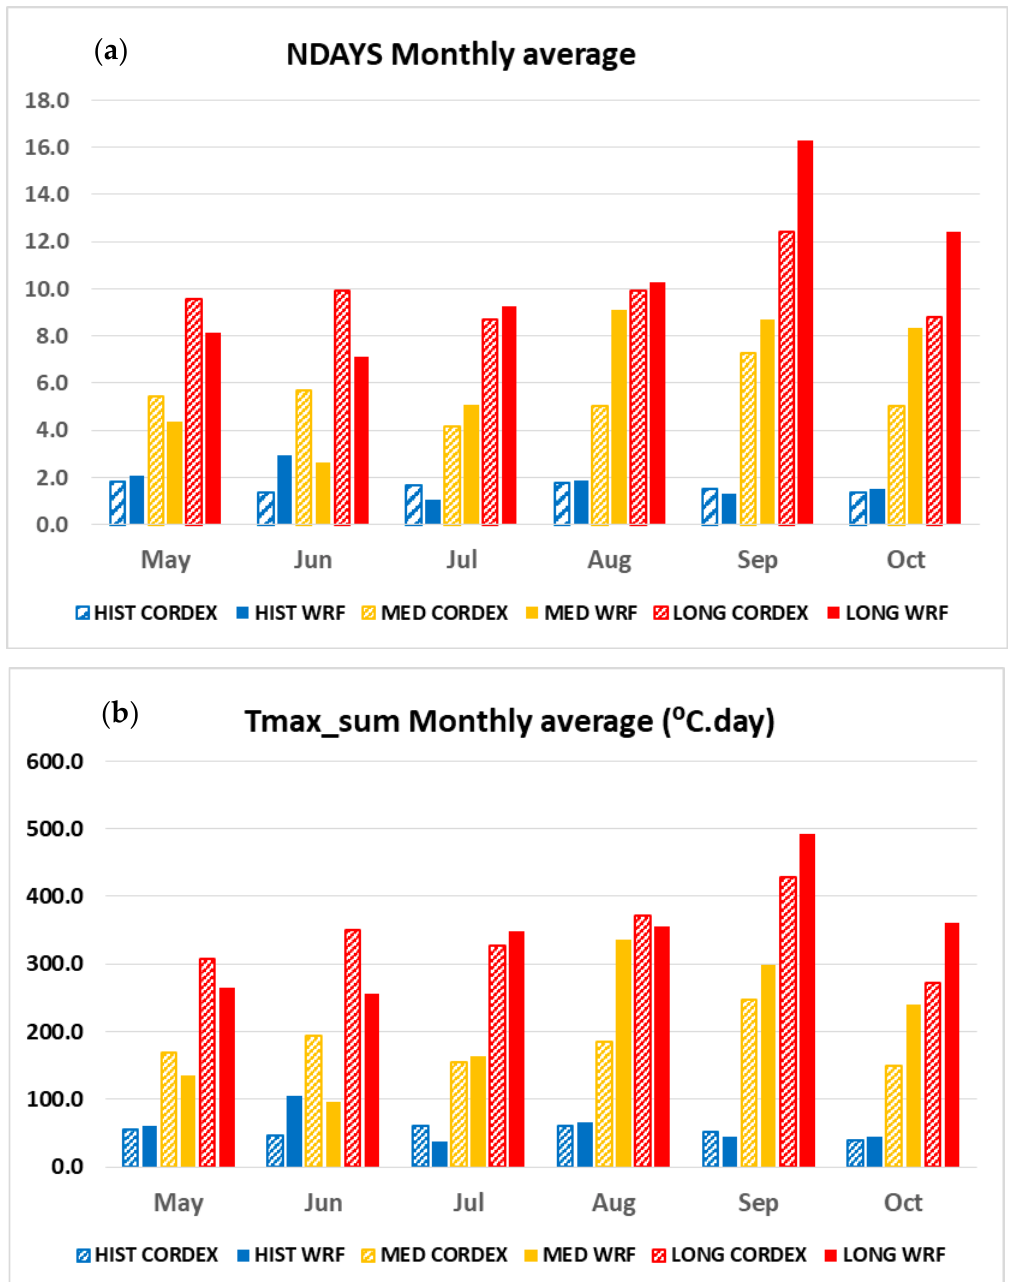
Figure 13. ( a ) NDAYS and ( b ) Tmax_sum monthly average for HIST, MED, and LONG simulated by WRF (full bars) and CORDEX ensemble average (dashed bars).